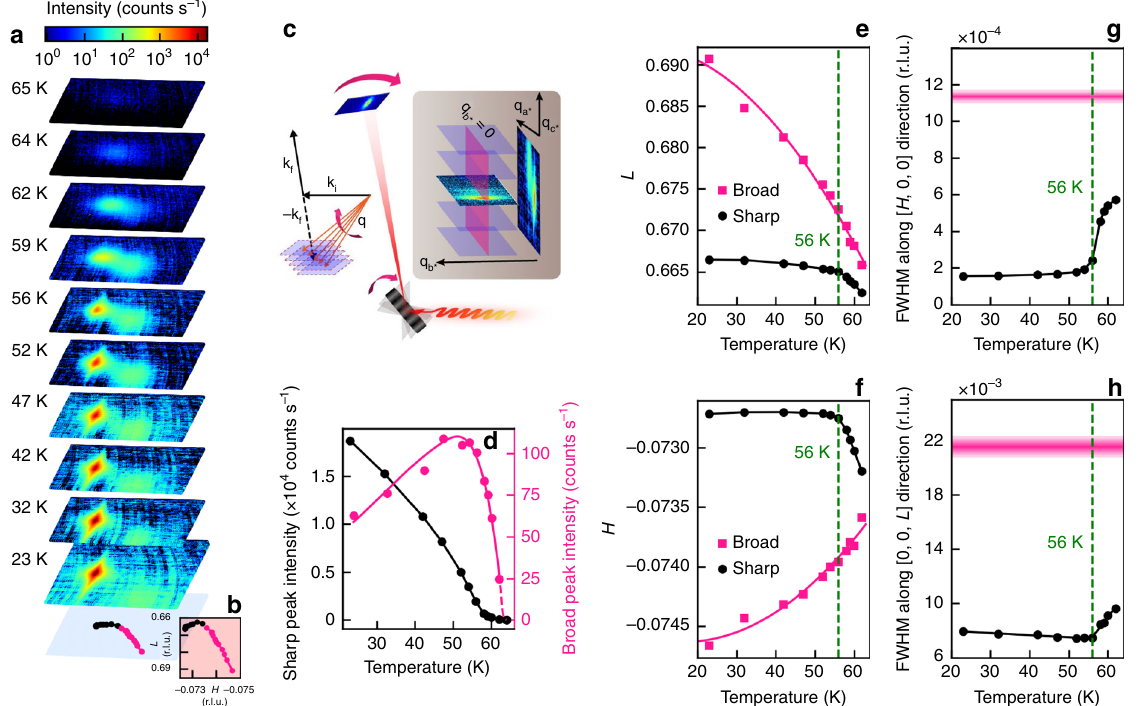
Fig. 2 Two coexisting signals in reciprocal space. a Reconstructed diffraction signals (see text and c ) in the ½ H ; 0 ; L (cid:5) plane at various temperatures. Each image ’ s fi eld of view is suf fi ciently large (note the larger fi eld of view of the 23 K data set) to include the maxima of both peaks, enabling reliable extraction of their intensities. Ring-like patterns are due to incomplete background subtraction, and not related to presence of any impurity phases in our sample. b Momentum-space trajectory of the two peak centers indicated at the bottom of a . c Schematics of momentum scan (see text) in real and reciprocal space. The inset displays how the ð H ; K ; L Þ volume data were reconstructed and the ð H ; 0 ; L Þ slice extracted. d Temperature dependence of the intensities of the sharp and broad peaks, determined from two-dimensional fi ts to the data (Supplementary Fig. 2). Lines are guide to the eye. e , f Temperature evolution of the momentum centoids of the broad and sharp peaks, projected along L and H directions, respectively. A leveling off is seen below ~56 K for the sharp peak. While the relative momentum changes can be determined quite precisely, there is a systematic uncertainty in the absolute readings of L and H caused by imperfect determination of the sample ’ s orientation matrix, which we estimate to be 0.002 and 0.001 r.l.u., respectively. g , h Temperature evolution of the full width at half maximum (FWHM) of the sharp peak in L and H , respectively. Horizontal shaded stripes indicate the FWHM (and its uncertainty) of the broad peak, which is weakly T